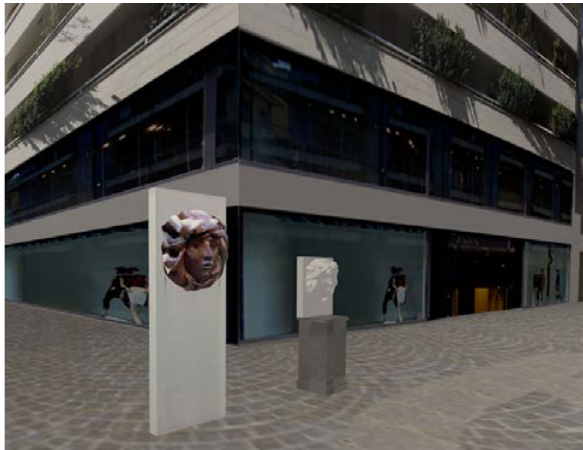
Figure 21. The model of The head of Medusa and of the miniature in the new